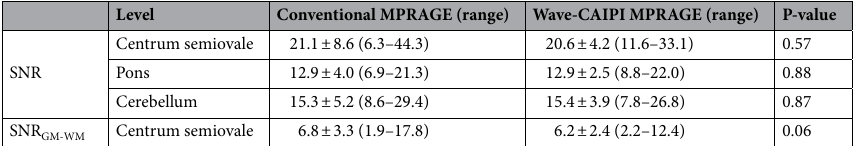
Table 4. Comparison of signal to noise ratio between conventional and wave-CAIPI MPRAGE. MPRAGE magnetization-prepared rapid gradient echo, GM grey matter, WM white matter, SNR signal to noise ratio, wave-CAIPI wave-controlled aliasing in parallel